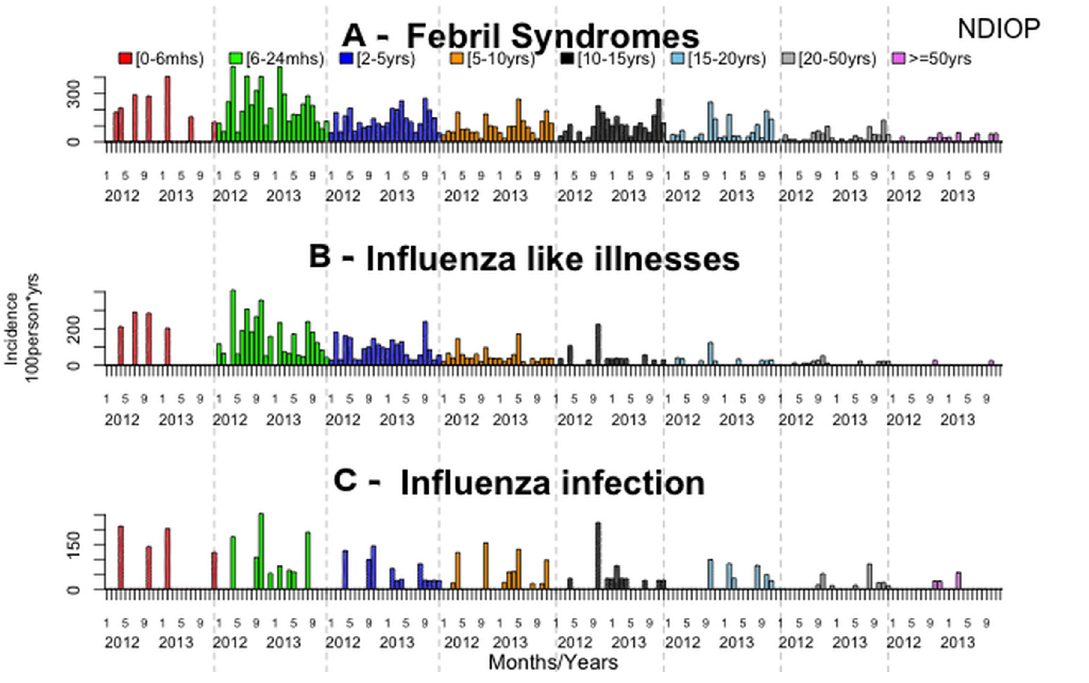
Fig 3. Monthly incidence density rates by age group in Ndiop, 2012 –